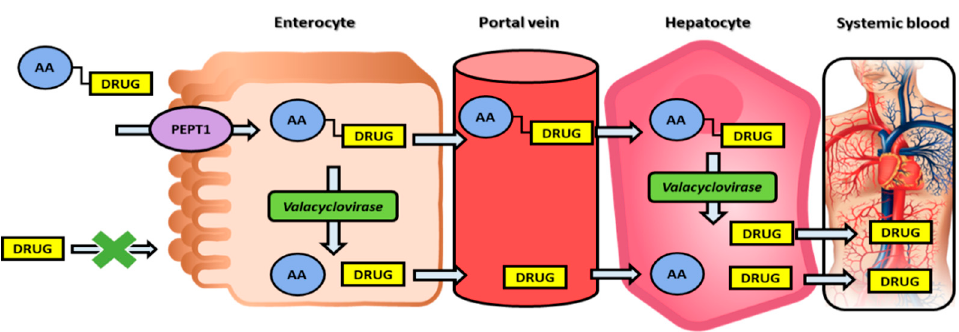
Figure 2. Double-targeted prodrug strategy illustration: binding to the PEPT1 transporter and activation through enzyme valacyclovirase. PEPT1, peptide transporter 1; AA, amino acid.